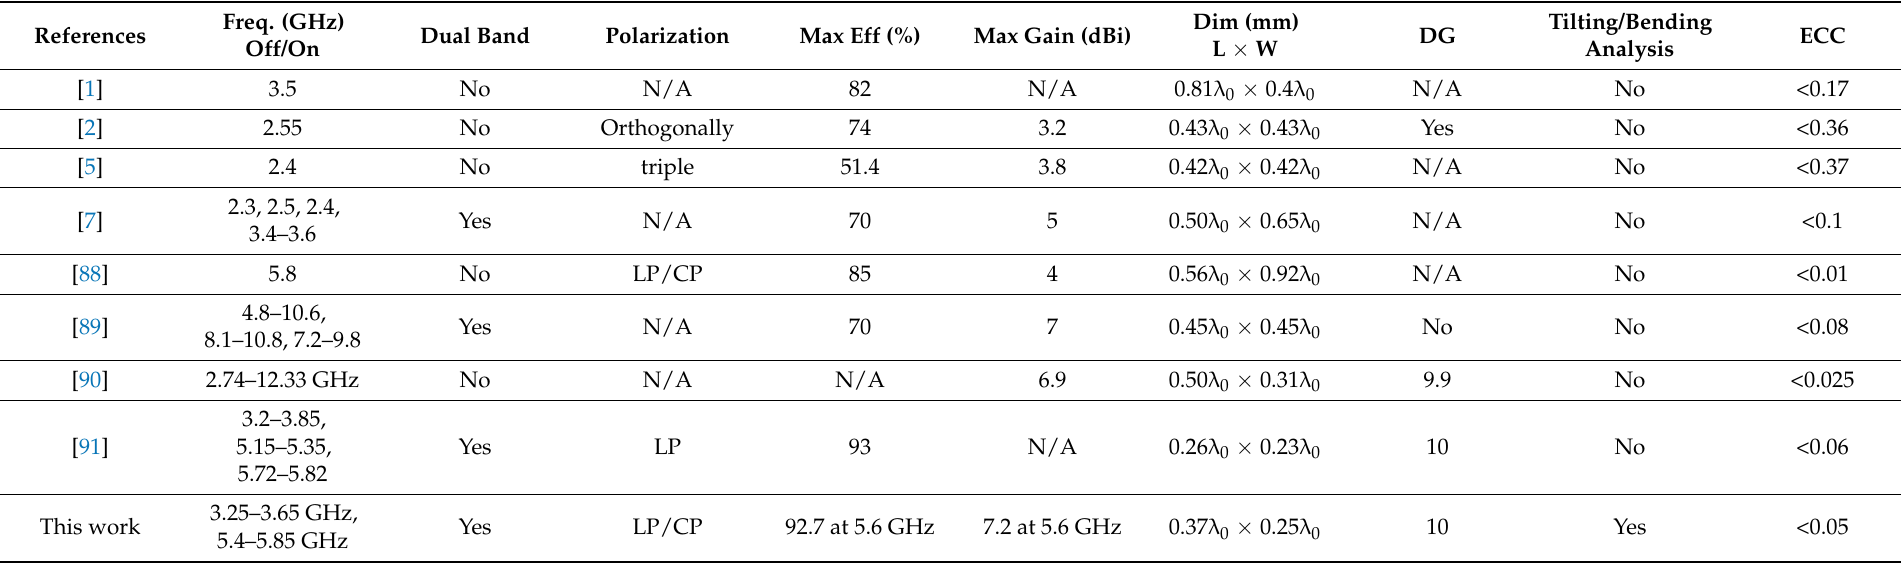
Table 4. Comparison of the proposed fabric antenna with previously reported work on MIMO antennas